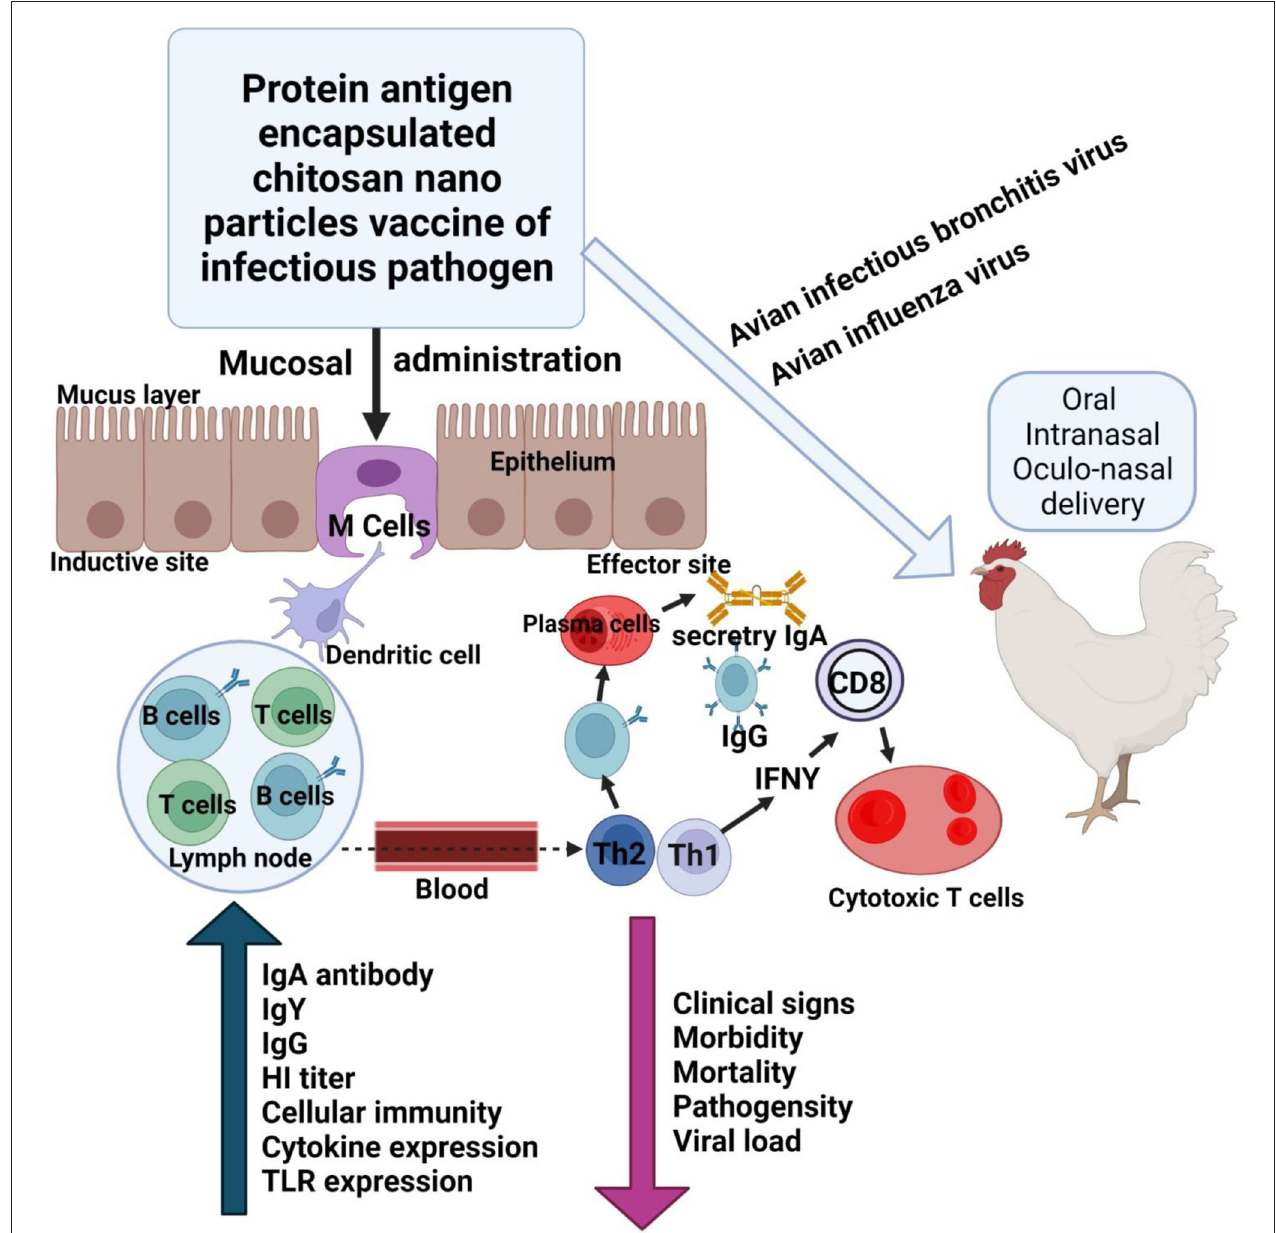
FIGURE 5 | Schematic illustration of the use of nanoparticles (chitosan) to deliver vaccine during IB and avian influenza to mucosal sites to induce immune response. The modified figure was redrawn with permission from Renu and Renukaradhya (133). Image created with Biorender.com.